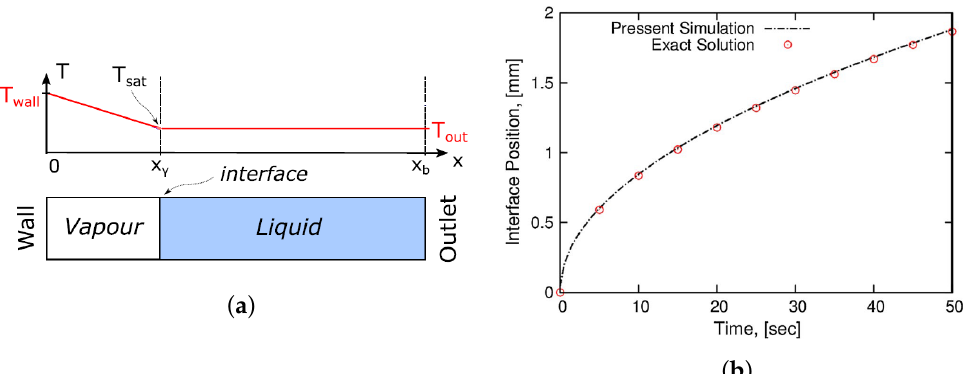
Figure 1. Stefan problem: ( a ) schematic, ( b ) comparison of the present numerical simulation (Fourier model) with the exact analytical